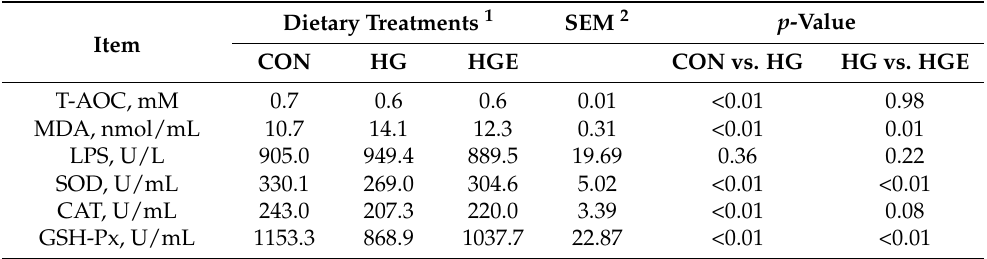
Table 8. Effects of vitamin E on plasma antioxidant capacity induced by high concentration in subacute ruminal acidosis cows.